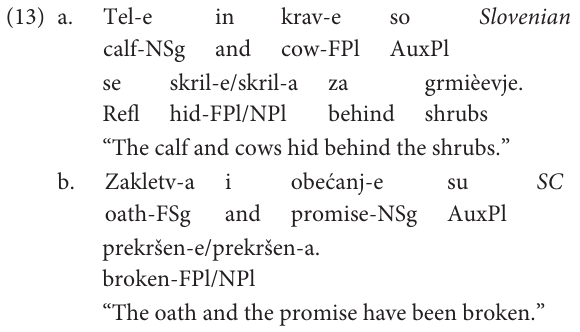
Marušiˇcetal.(2015)isprobablyduetoastrongfacilitatingeffectofthePlconjunct.